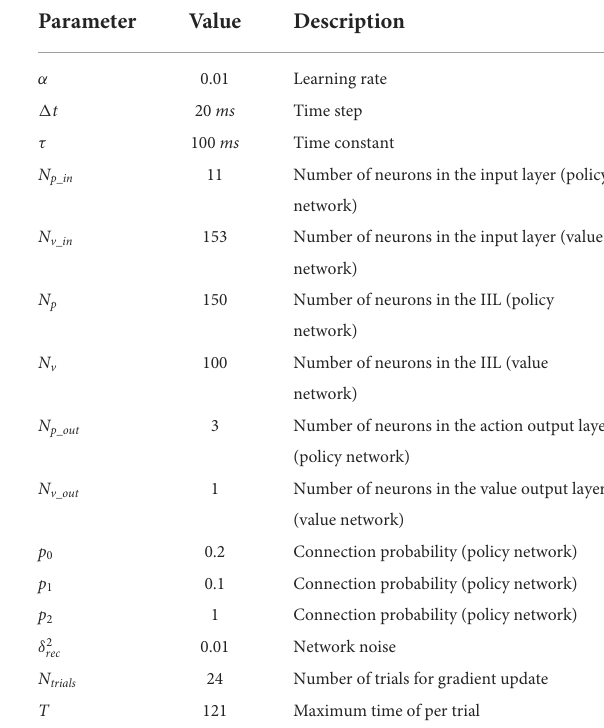
TABLE 1 Training parameters of the deep RL